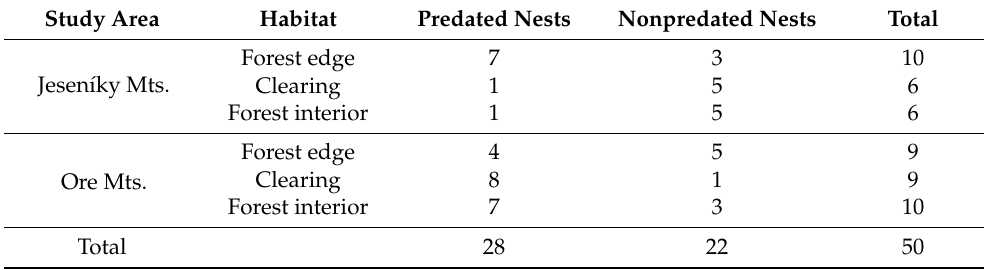
Table 1. Numbers of predated and non-predated nests within each study area and for three habitat